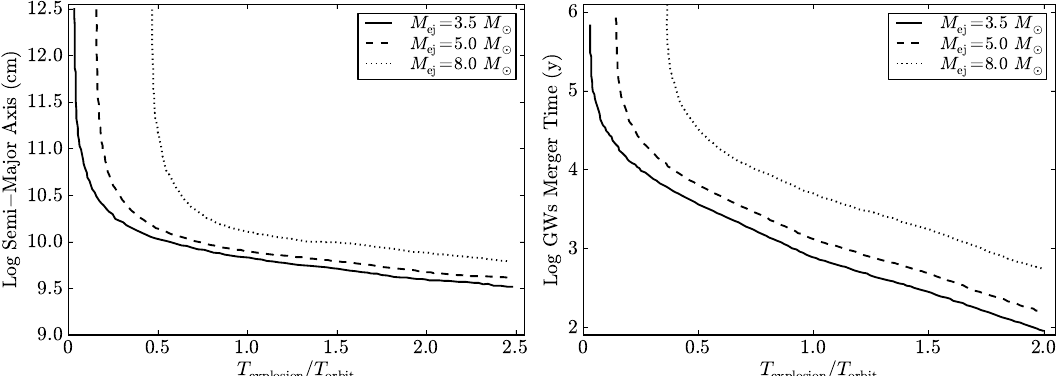
Figure 12. ( a ) Semi-major axis versus explosion time for three different mass ejecta scenarios: 3.5 M (solid), 5.0 M (dotted), 8.0 M (dashed), including mass accretion and momentum effects (taken from (cid:12) (cid:12) Figure 2 in [55]). Including these effects, all systems with explosion times above 0.7 times the orbital time are bound and the final separations are on par with the initial separations. ( b ) Merger time due to gravitational wave emission as a function of explosion time for the same three binaries of the left panel (taken from Figure 3 in [55]). Note that systems with explosion times 0.1–0.6 T orbit have merger times less than roughly 10 4 y. For most of our systems, the explosion time is above this limit and we expect most of these systems to merge